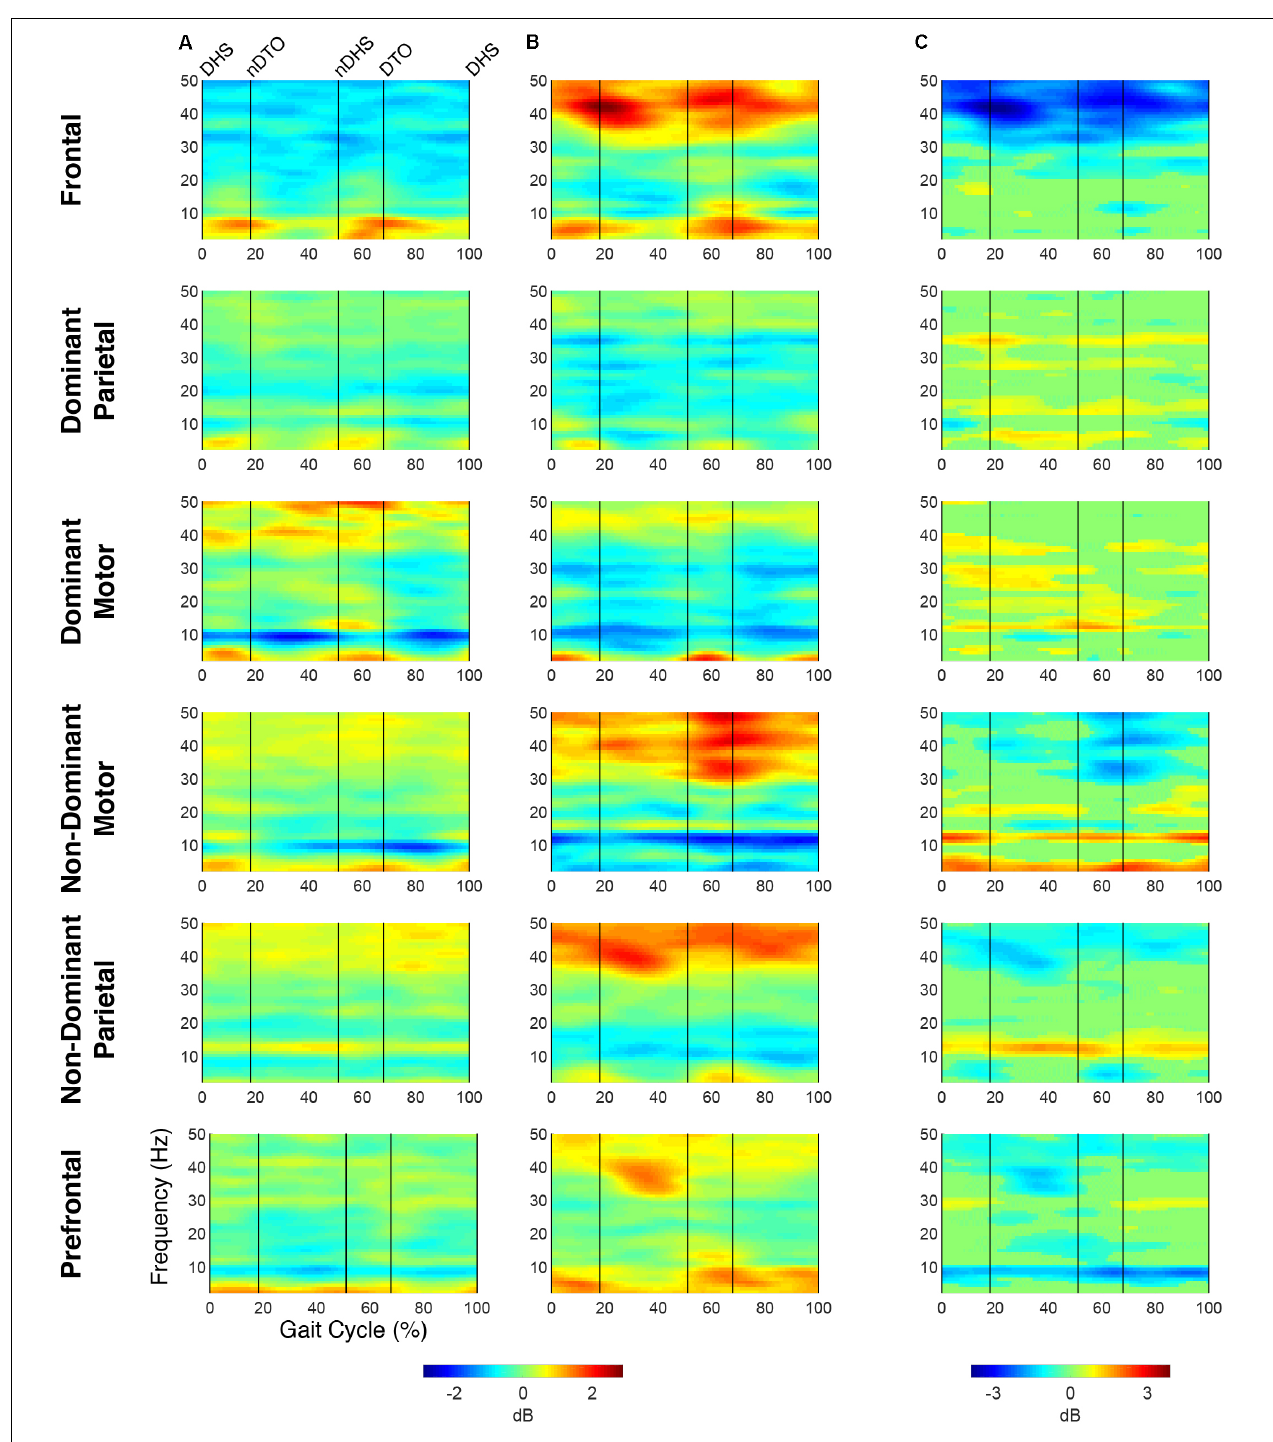
FIGURE 2 | Time-frequency activity relative to quiet standing during treadmill walking. Grand mean event-related desynchronization (ERD)/event-related synchronization (ERS) plots for each cortical cluster in (A) TD and (B) CP, displayed in dB. (C) Between group differences of spectrograms calculated by subtracting grand mean ERD/ERS plots in CP from TD, displayed in dB. Difference spectrograms were masked for significance (alpha < 0.05); non-significant values were set to 0 dB (green).